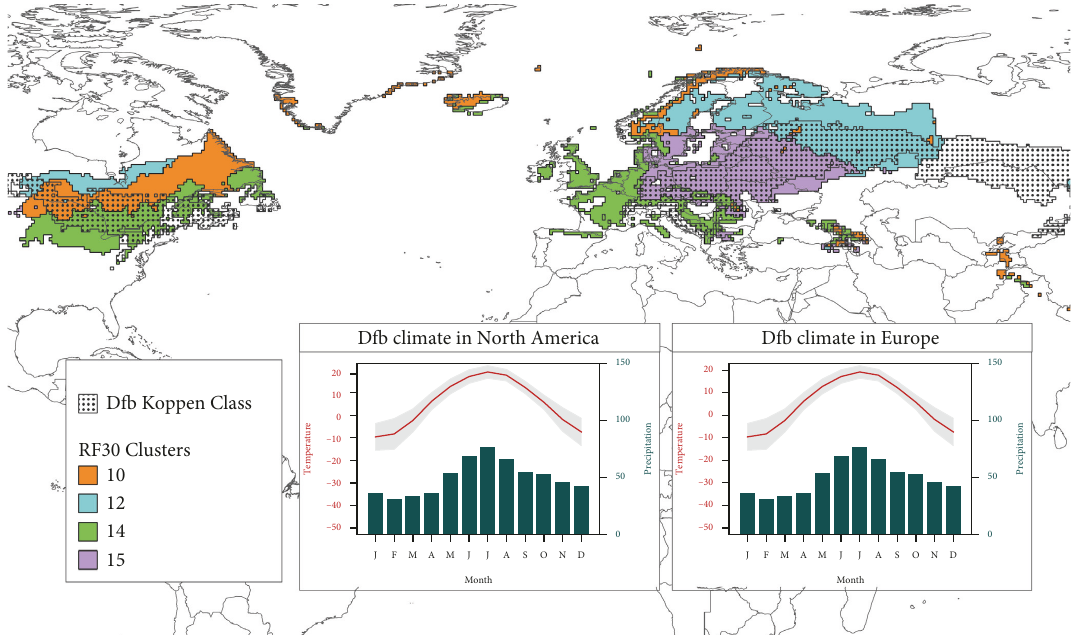
Figure 15: Dfb warm summer continental KG class and the overlapping RF30 clusters. Inset climographs are for the two parts of Dfb classes in Eurasia and North